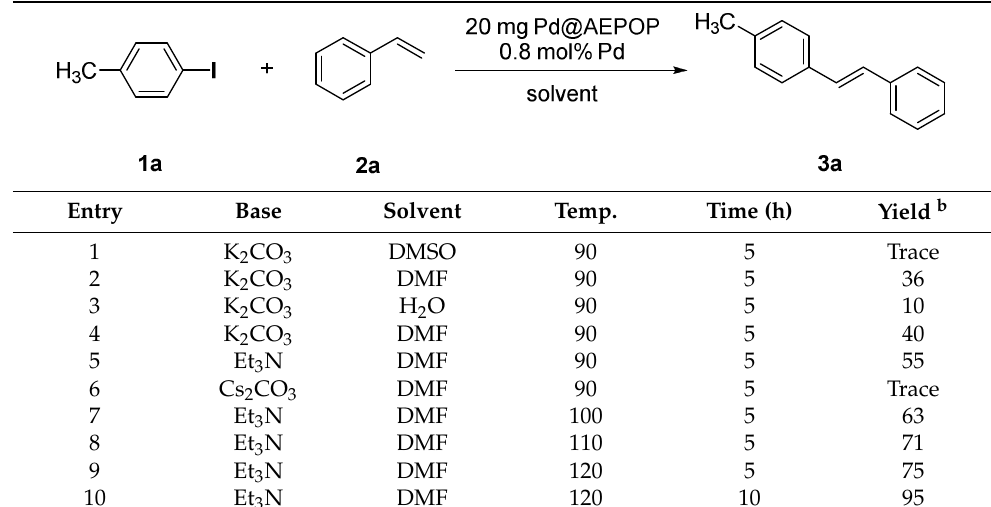
Table 1. Identification of reaction conditions a .